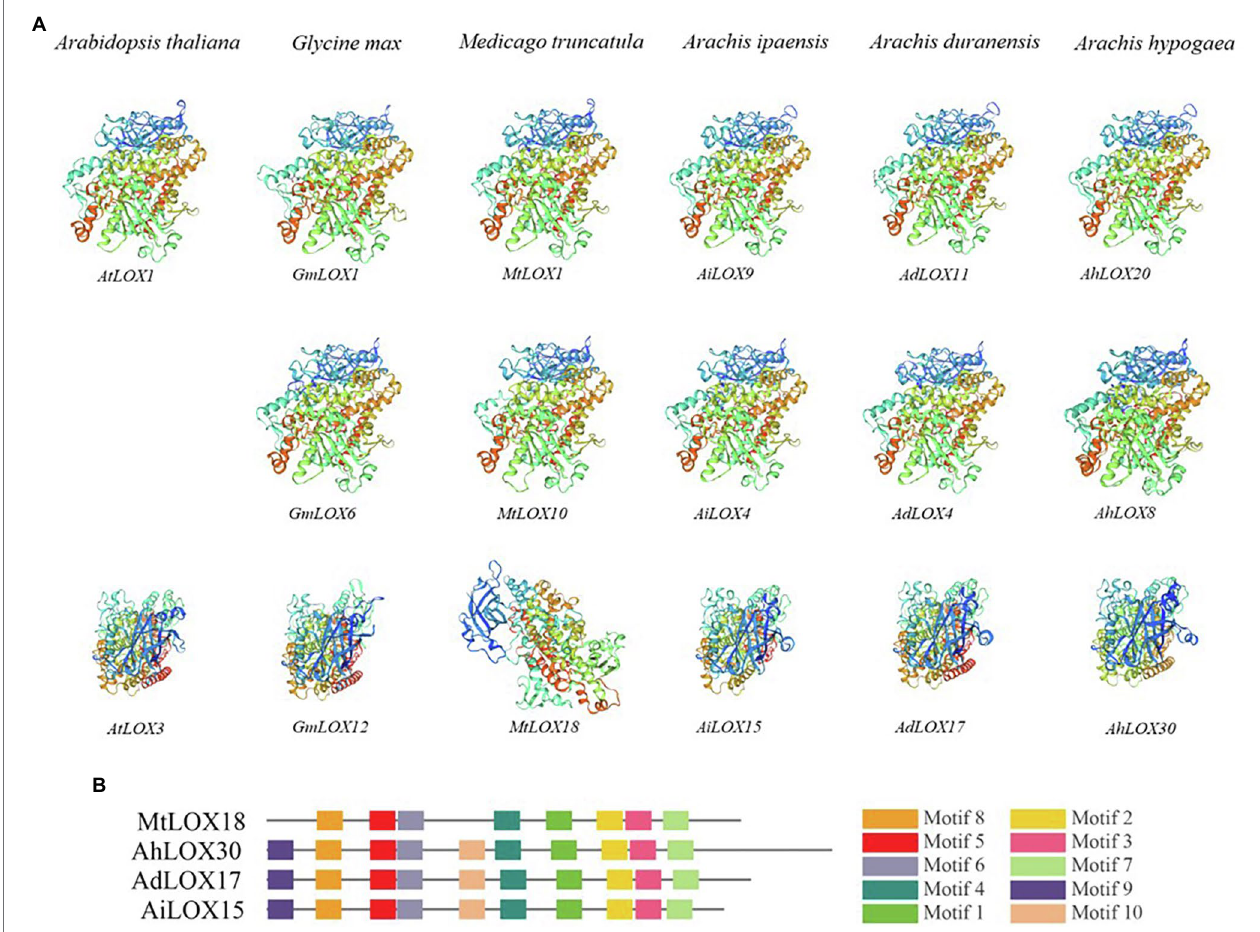
FIGURE 1 | Predicted structures of LOX proteins. The modeled structures of LOX genes from different species are displayed. 9-LOX (AtLOX1, GmLOX1, MtLOX1, AiLOX9, AdLOX11, and AhLOX20), type I 13-LOX (GmLOX6, MtLOX10, AiLOX4, AdLOX4, and AhLOX8) and type II 13-LOX (AtLOX3, GmLOX12, MtLOX18, AiLOX15, AdLOX17, and